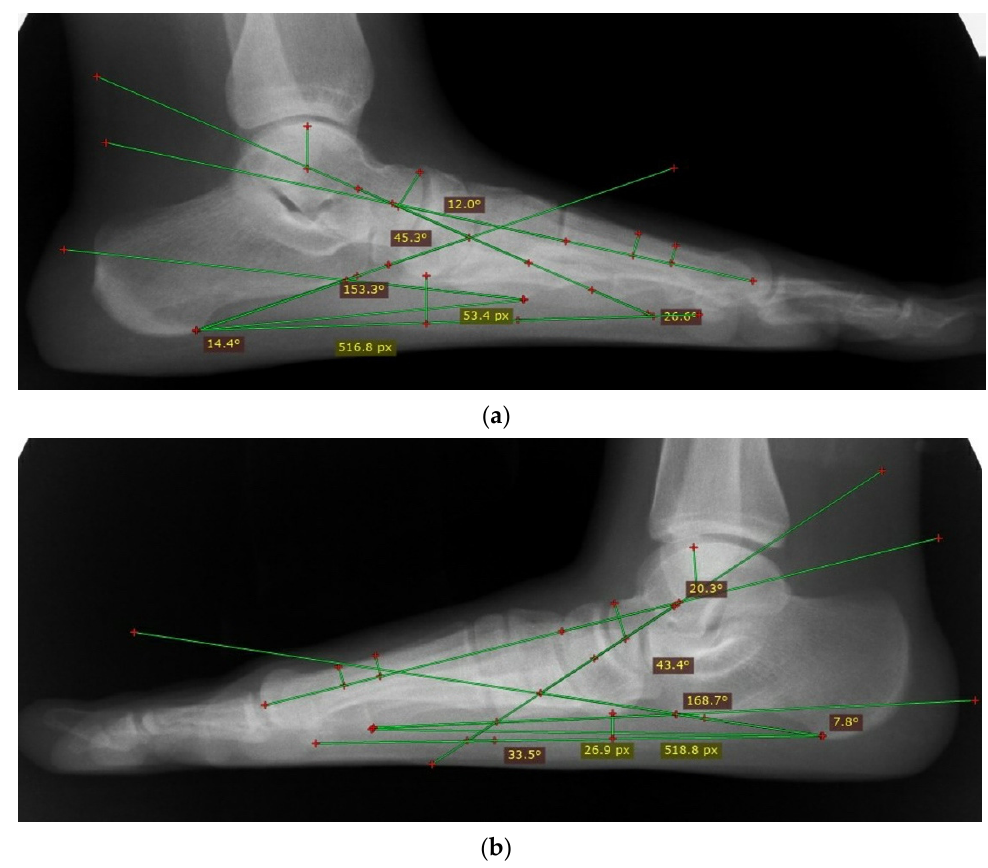
Figure 2. ( a ): Lateral radiographic assessment of a normal weight-bearing foot demonstrating the arch angle = 153.3°, CP angle = 26.6°, TFM = 12°, TIA = 14.4°, LTA = 45.3°, and NI = 9.68. ( b ): Lateral radiographic assessment of a flatfoot weight-bearing foot demonstrating the arch angle = 168.7°, CP angle = 7.8°, TFM = 20.3°, TIA = 33.5°, LTA = 43.4°, and NI =19.5.